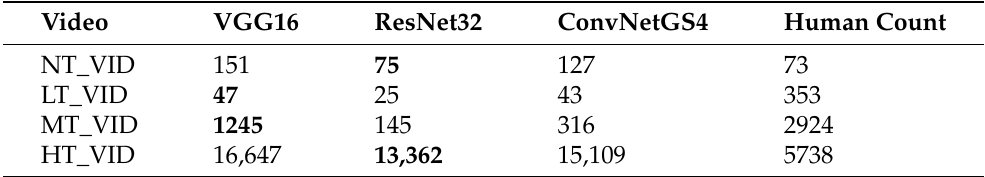
Table 12. Performance of 2TA on 4 videos: columns VGG16, ResNet32, ConvNetGS4 give the bee motion counts returned by configurations MOG2/VGG16, MOG2/ResNet32, MOG2/ConvNetGS4, respectively; last column gives human bee motion counts for each video; counts closest to human counts in righmost column are in